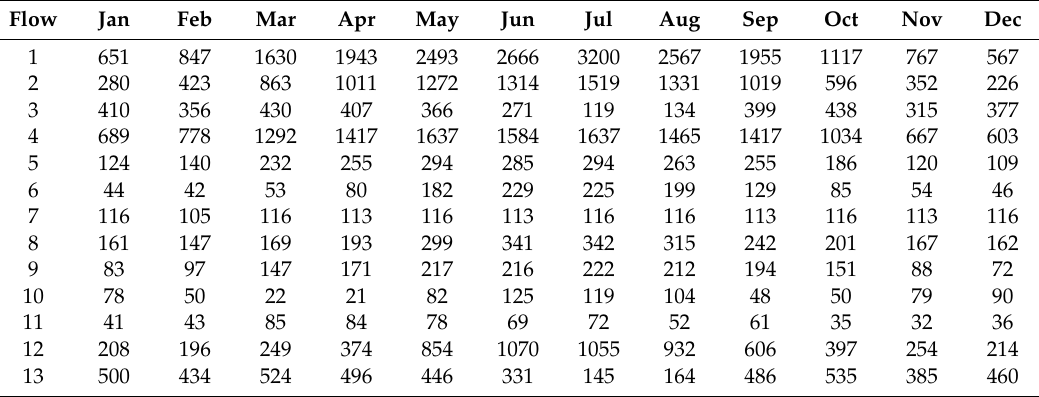
Table 2. Monthly energy balance of the hybrid solar parabolic trough–ORC–biomass plant (system A), MWh /